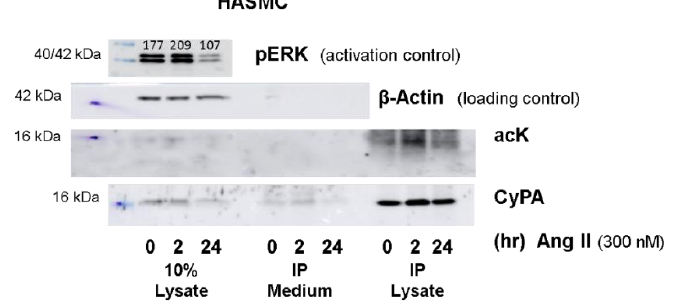
Figure 5. Western blot analysis of released Cyclophilin A in HASMCs. HASMCs were stimulated